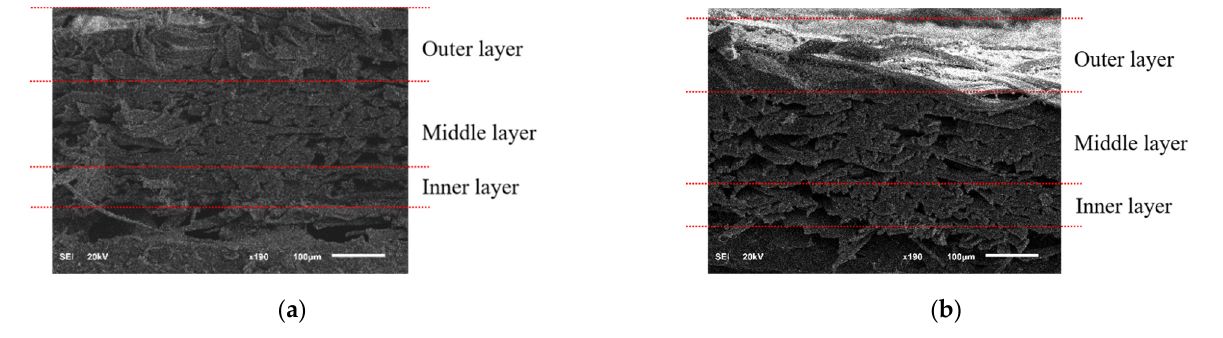
Figure 8. The cross section of the cocoon: ( a ) A. pernyi (H), ( b ) A. pernyi (L). Table 2. Fiber bonding length of different cocoon layers.